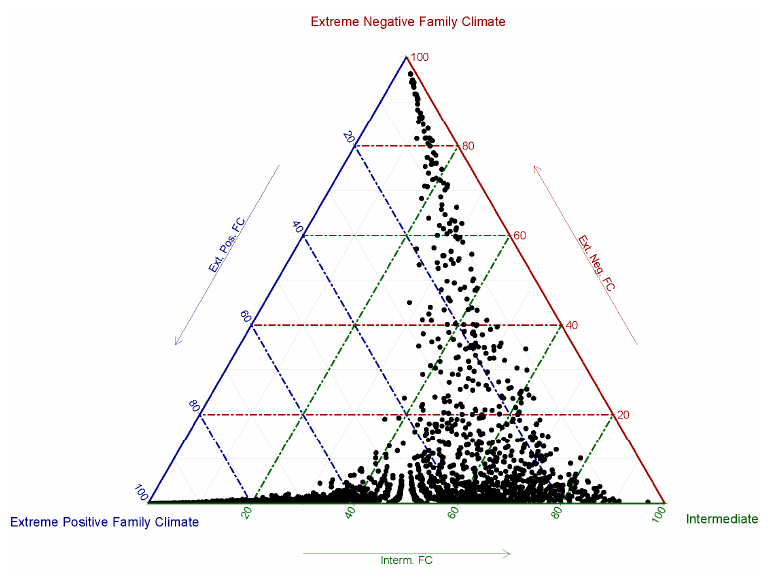
Figure 1. Fuzzy Clustering Ternary Graph.